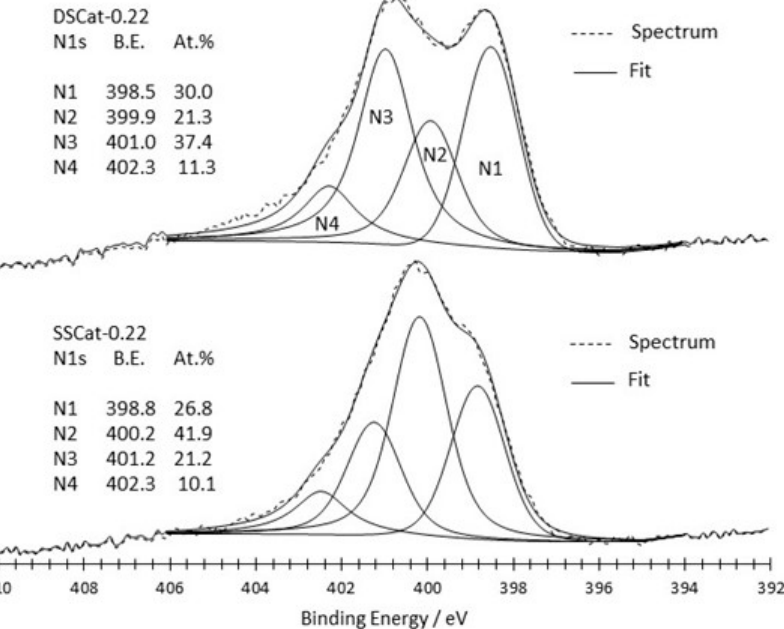
Figure 3. Comparison of N1s peak fitting for SSCat-0.22 and DSCat-0.22 catalysts.